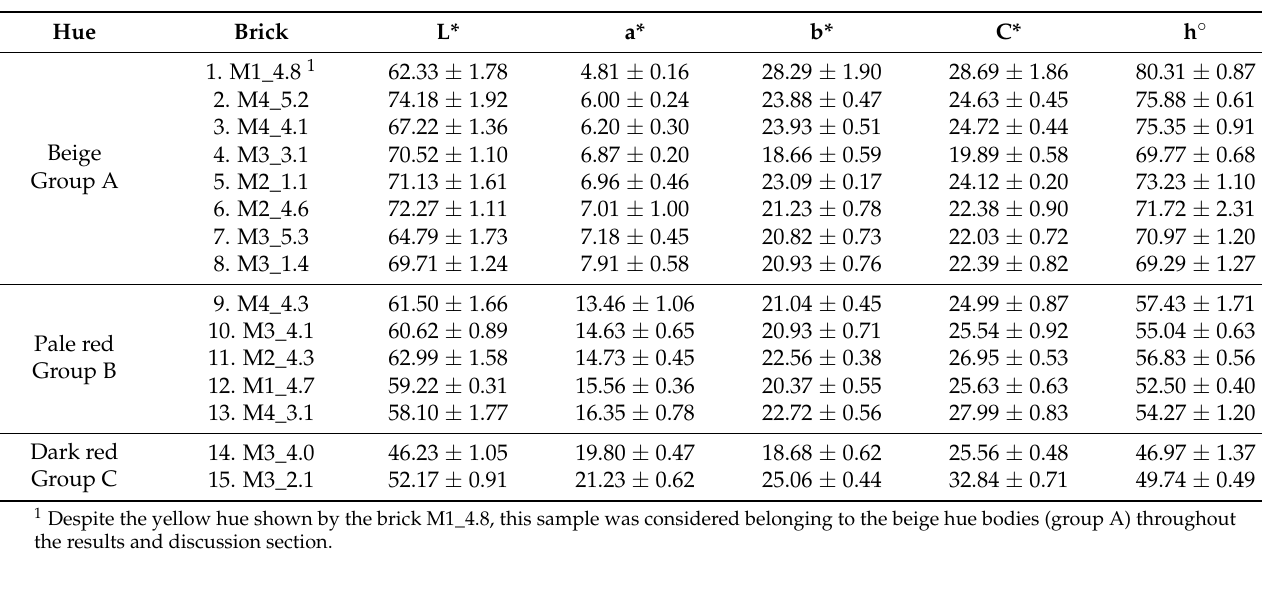
Table 1. Average and Std of lightness (L*), chromatic coordinates (a* and b*), chroma (C*) and hue angle (h ◦ ) of the ceramic bodies.